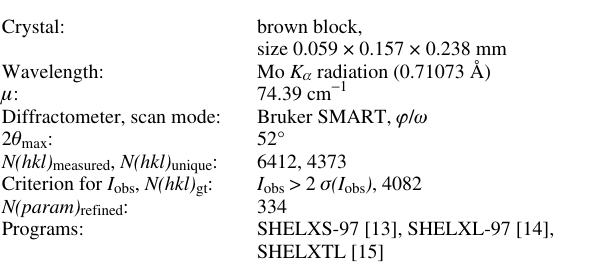
Table 1. Data collection and handling.